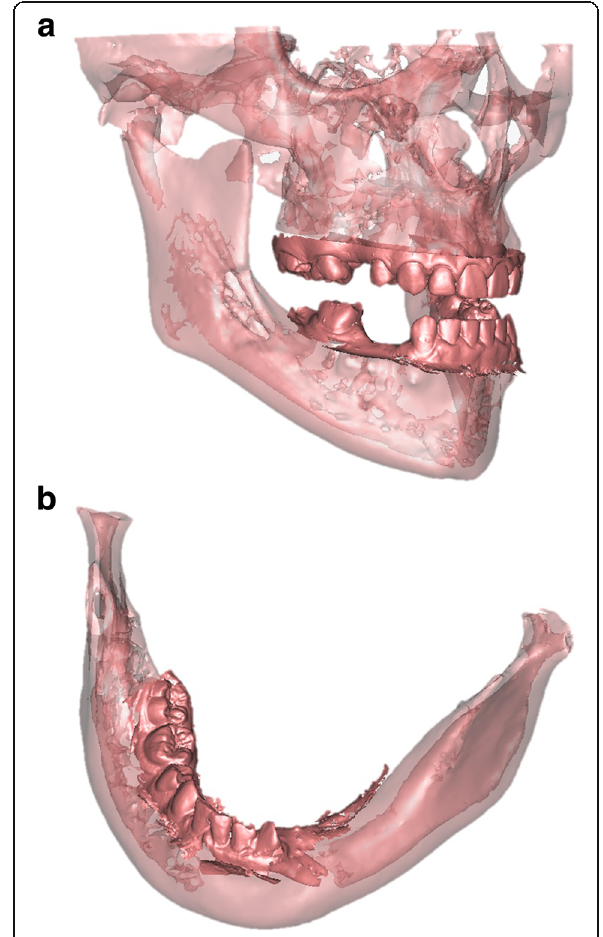
Fig. 3 a Patient 1 — detailed 3D model of the combined data from the CBCT and intra-oral scan at age of 18. b Patient 2 — detailed 3D model of the combined data from the CBCT and intra-oral scan at age of